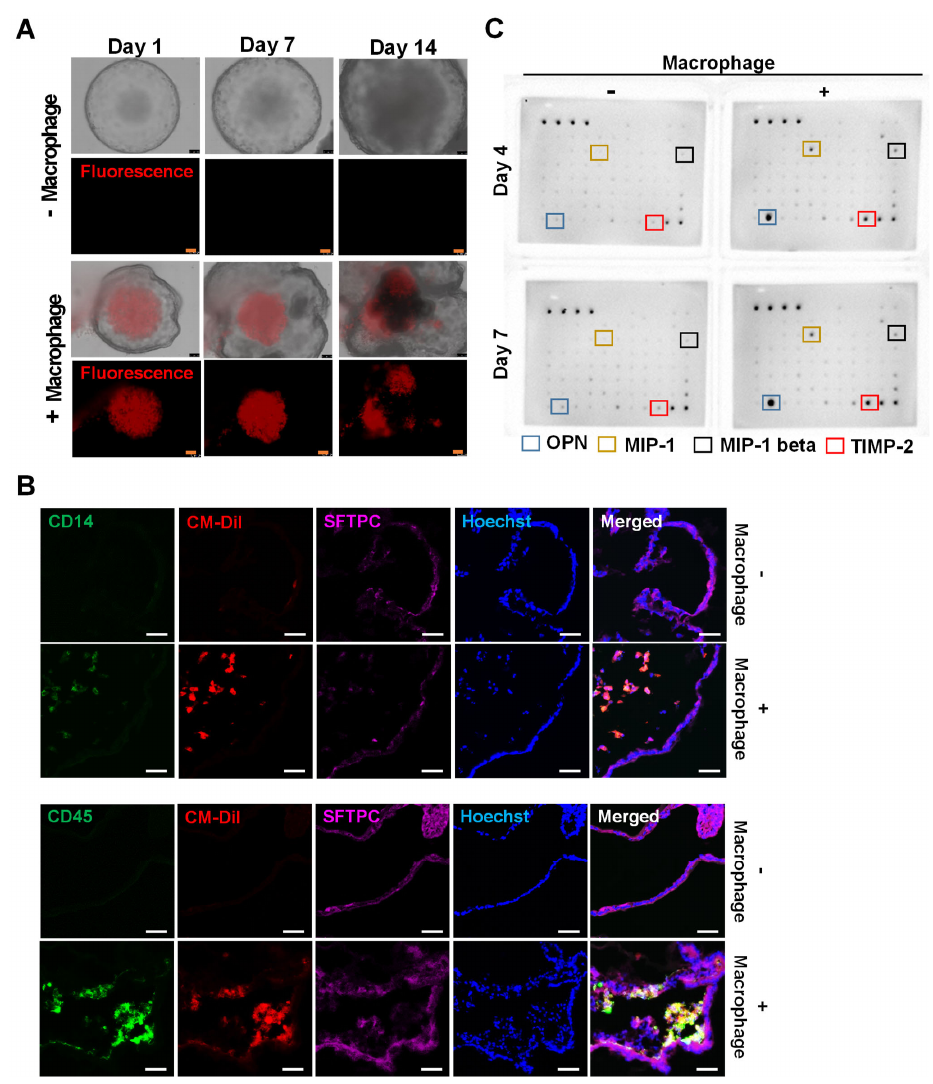
Figure 4. Induction of hESC ‐ derived macrophages in lung organoid. ( A ) Representative phase ‐ contrast and fluorescent dye images of lung organoids injected with macrophages at injection day 1 to 14. The red fluorescent cells indicated the injected macrophages. Scale bar = 100 μ m. ( B ) Immuno ‐ fluorescence images of lung organoids and injected macrophages. Scale bar = 50 μ m. ( C ) Cytokine array images of lung organoid with or without macrophages at day 7 after injection.